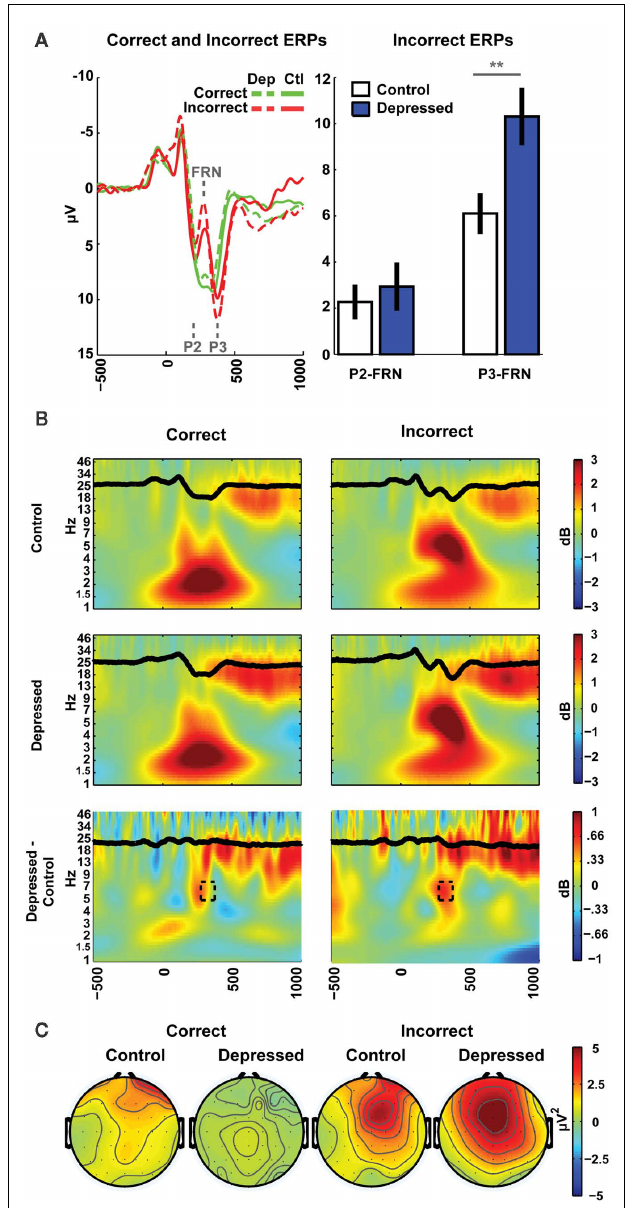
FIGURE 2 | EEG results. (A) The depressed group was characterized by a larger P3-FRN amplitude in the ERP to incorrect feedback. (B) Time–frequency plots show the theta band dynamics that occur following incorrect feedback (ERPs are superimposed in black).The time and frequencies of interest associated with the P3-FRN are identified by the dashed box in the difference plot. (C) Theta power during this time range showed a strong mid-frontal distribution for incorrect